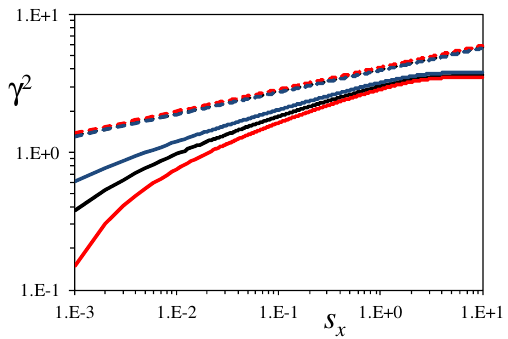
Fig. A2. Power variogram (dashed curves) and truncated power variogram with Gaussian modes (continuous curves) obtained with the parameters estimated in Fig. 14a on the basis of S 1 (red curves), N S 2 (blue curves), and S 1 and S 2 jointly (black N N N